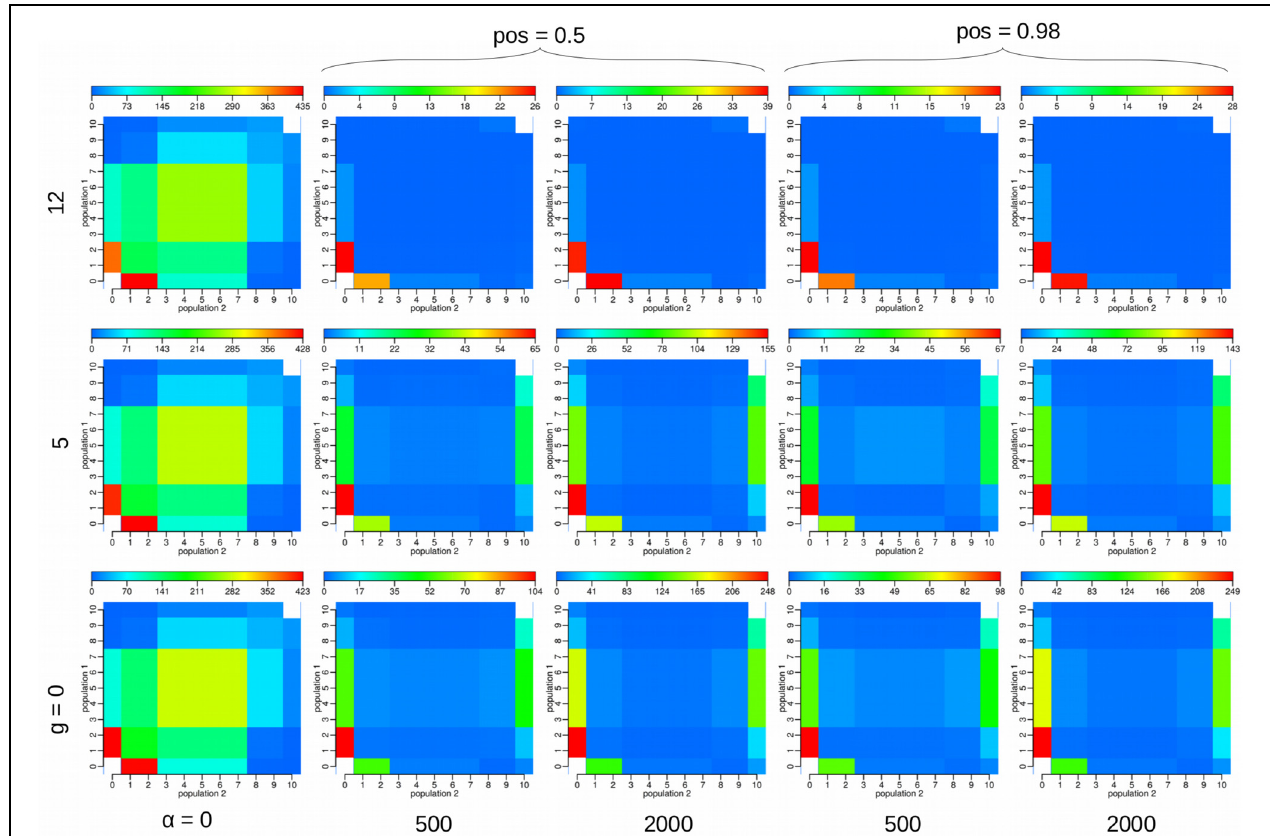
FIGURE 2 | We visualized the average values of the 23 summary statistics (SS) used with three differing parameters under the SizeChange model under a complete sweep scenario: selection strength α = 2 N e s , the exponential growth rate g of the second population in which also the selected allele arises, and the position of the selected allele pos . For each plot we ran 100 replicates of 100 loci each of 1 kb in length, with 10 samples from each population. For example, the field [2,3] in the matrix represent the number of SNPs found in exactly two samples in population 1 and three